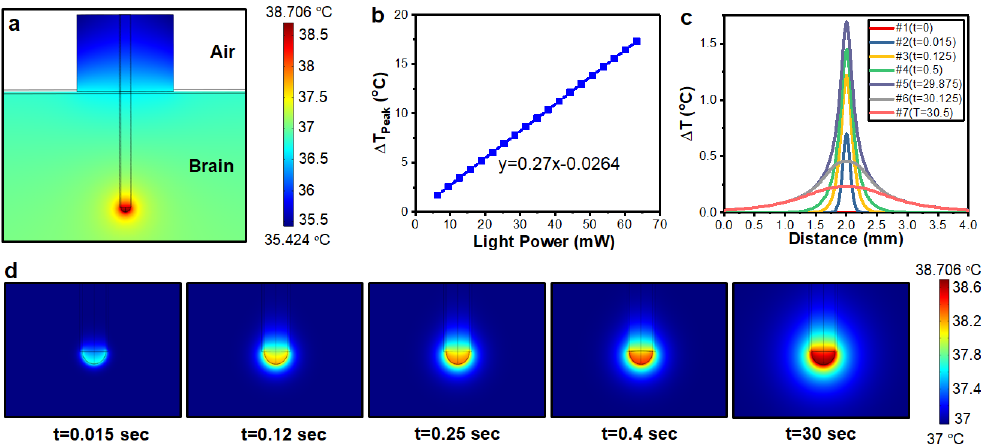
Figure 3. Simulation results of the temporal temperature changes of the TP optical fiber. ( a ) Simulation results of the temperature changes on the brain (penetration depth: 1.4 mm, heat rate: 1 mW, equivalent laser power: 15.8 mW, 30 s). ( b ) Peak temperatures of the brain under light power increases. ( c , d ) One-dimensional (1D) and 2D plots of temporal temperature changes of the brain by photothermal stimulation (penetration depth: 1.4 mm; heat rate: 1 mW; equivalent laser power: 15.8 mW; 40 s with 30 s of laser irradiation).